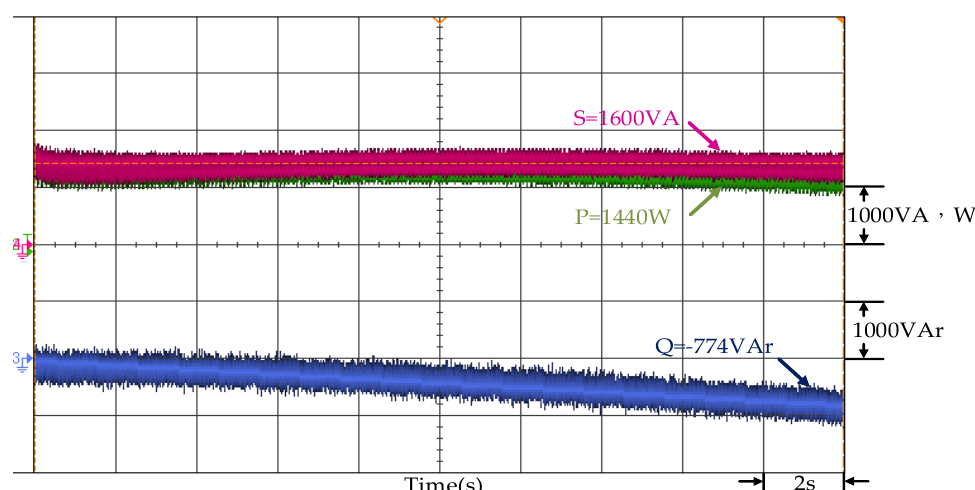
Figure 21. The output power regulation of the smart inverter when the per-unit value of mains voltage was between 0.97 p.u. and 1 p.u.